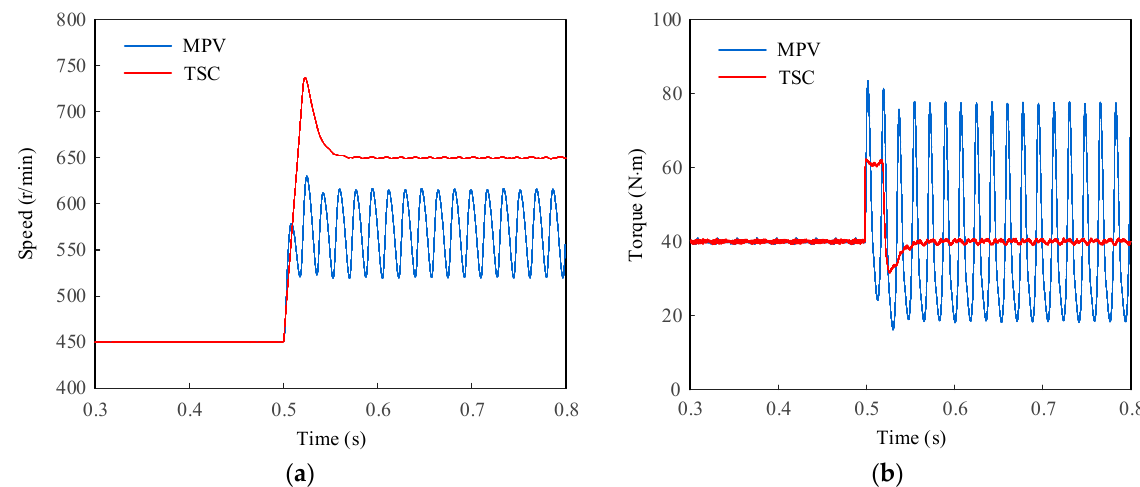
Figure 12. Improved given speed simulation results for the MPV and TSC control for faulty dual three-phase PMSM. ( a ) Speed. ( b ) Torque.